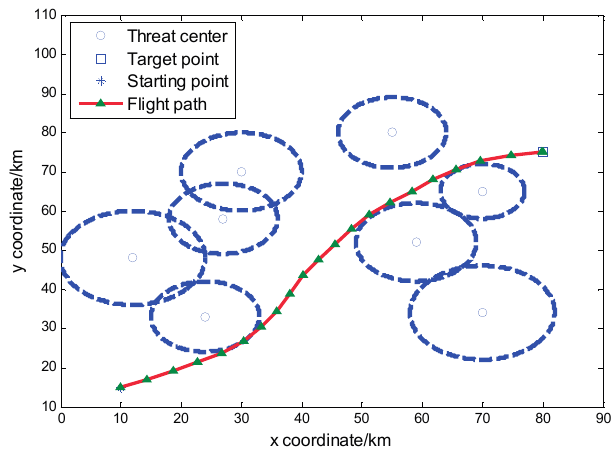
Figure 13. Result of the second instance for Maxgen =